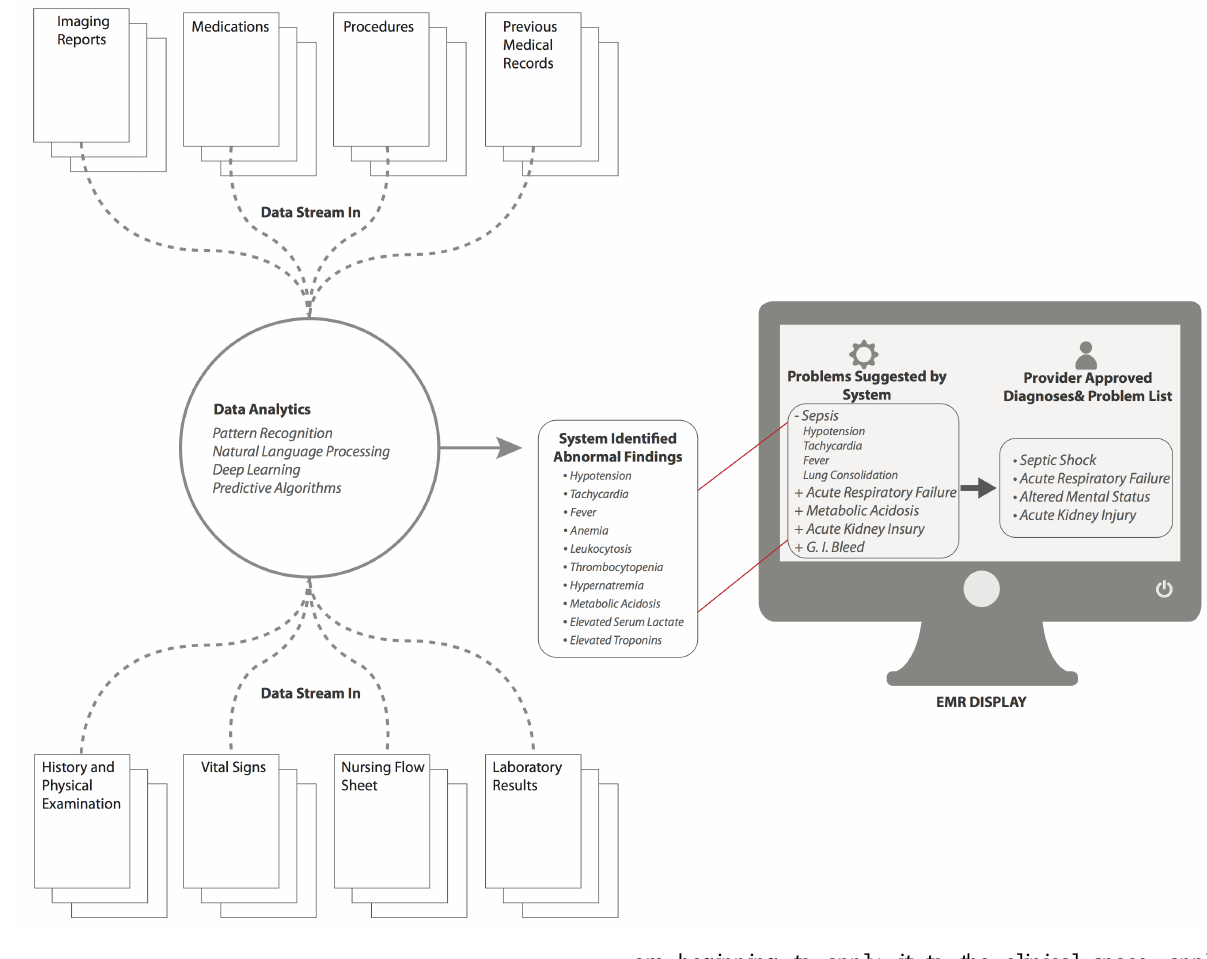
Figure 3. Mock screenshot for the "Assessment and Plan" screen with background data analytics. Based on background analytics that are being run by the system at all times, a series of "problems" are identified and suggested by the system, which are then displayed in the EMR in the box on the left. The clinician can then select problems that are suggested, or input new problems that are then displayed in the the box on the right of the EMR screen, and will now be apart of ongoing analytics for future